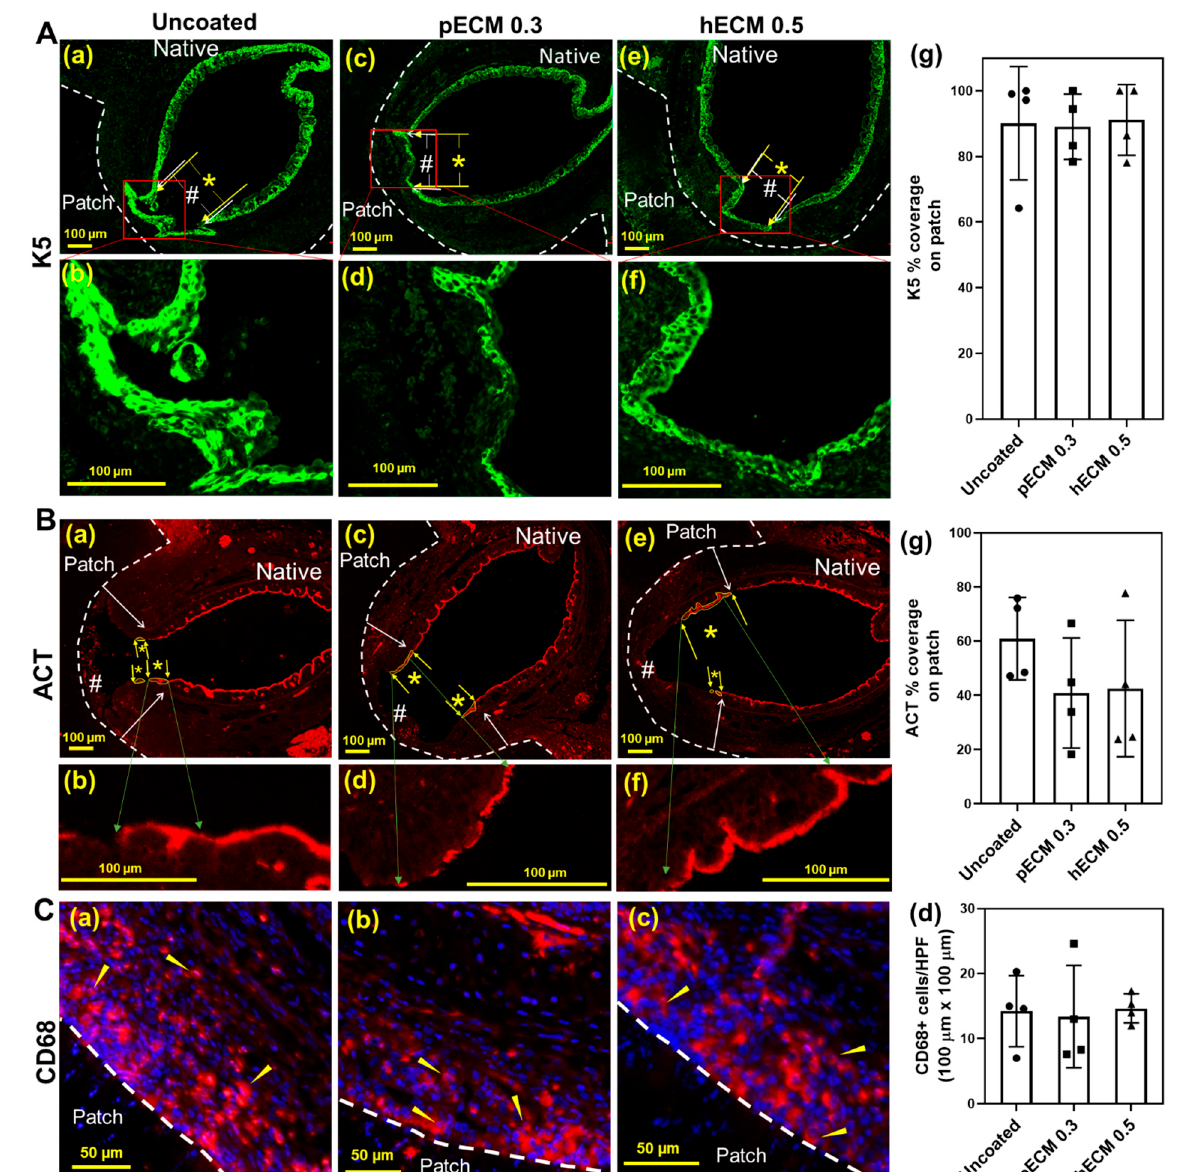
Figure 4. Immunofluorescence characterization of a basal epithelial cell (K5), ciliated epithelial cell (ACT), and macrophage (CD68) on patch syn-TG. ( A ) Representative IF images of basal epithelial cells (K5, green, (a)~(f)) in tracheas implanted with uncoated, pECM 0.3-mg/mL, and hECM 0.5-mg/mL-coated patches (scale bar = 100 µm); dashed lines mark the edges of the patches; in (a),(c),(e), * denotes the width of the neo-epithelium; # denotes the total width of the intraluminal syn-TG patch between the arrows. (g) Quantified coverage of the patch with basal (K5) (% coverage). ( B ) Representative IF images of ciliated epithelial cells (ACT, red, (a)~(f)) in (a),(c),(e); * and # are identical nomenclature for the coverage with ciliated epithelium (ACT). (g) Quantified coverage of the patch with ciliated (ACT) cells (% coverage). ( C ) Representative IF images of CD68+ macrophages (arrowheads mark the red cells) in the submucosa over the patch: uncoated (a), a pECM 0.3-mg/mL-coated patch (b), and a hECM 0.5-mg/mL-coated patch (c). (d) Quantification of the macrophages (cells/100 µm × 100 µm area) in the neo-epithelium.